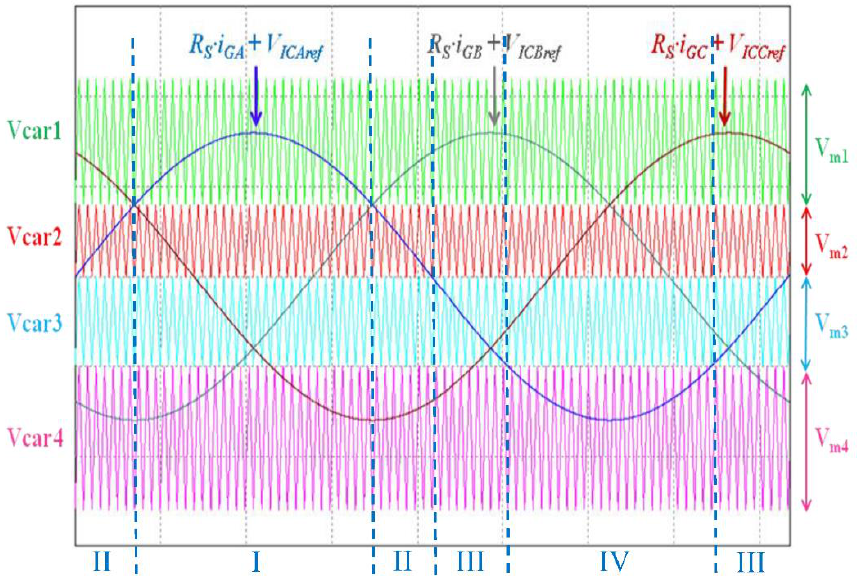
Figure 2. Proposed multi-carrier level-shifted OCC control with variable carrier-amplitude.